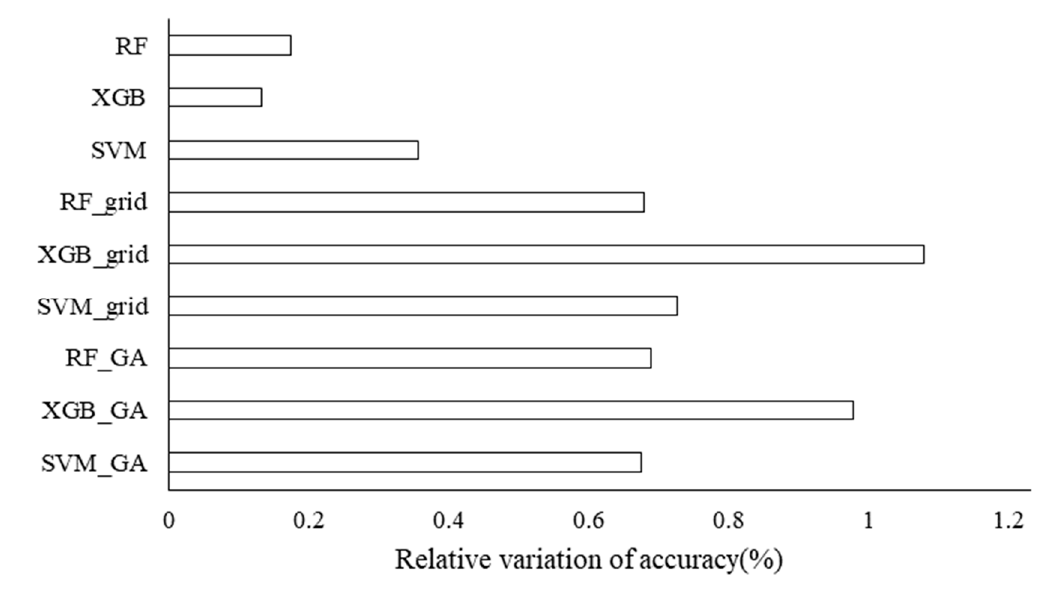
Figure 5. The relative variation of accuracy of ML models with default and optimized hyper-parameters using a genetic algorithm and grid search method from validation site to transfer site.